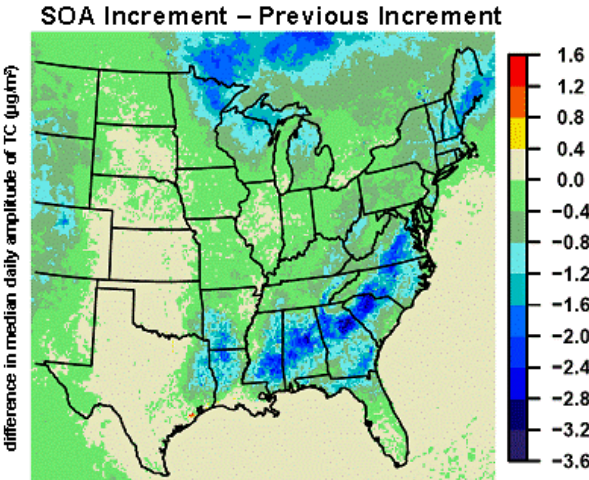
Fig. 4. Difference in the median of daily amplitudes (daily max – daily min) for TC (µg/m 3 ) between the SOA module update and the previous model version for August